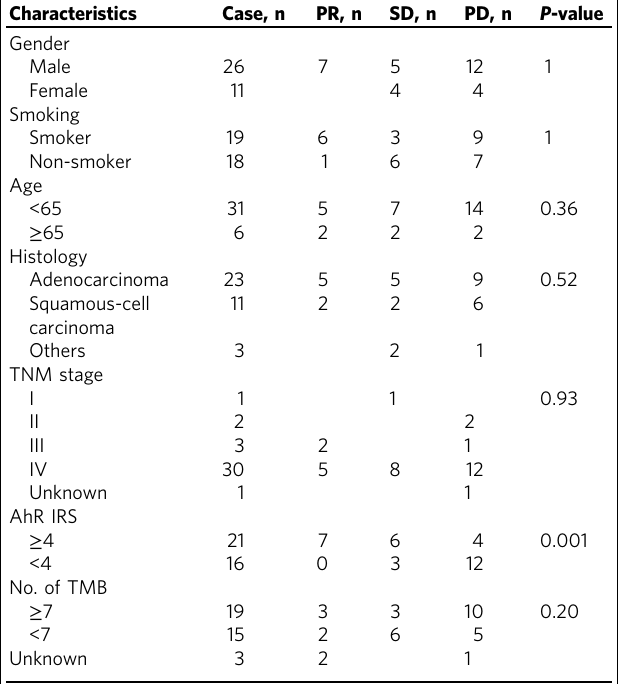
PR partial response, SD stable disease, PD progression of disease, P value patients achieved PR and SD versus cases with